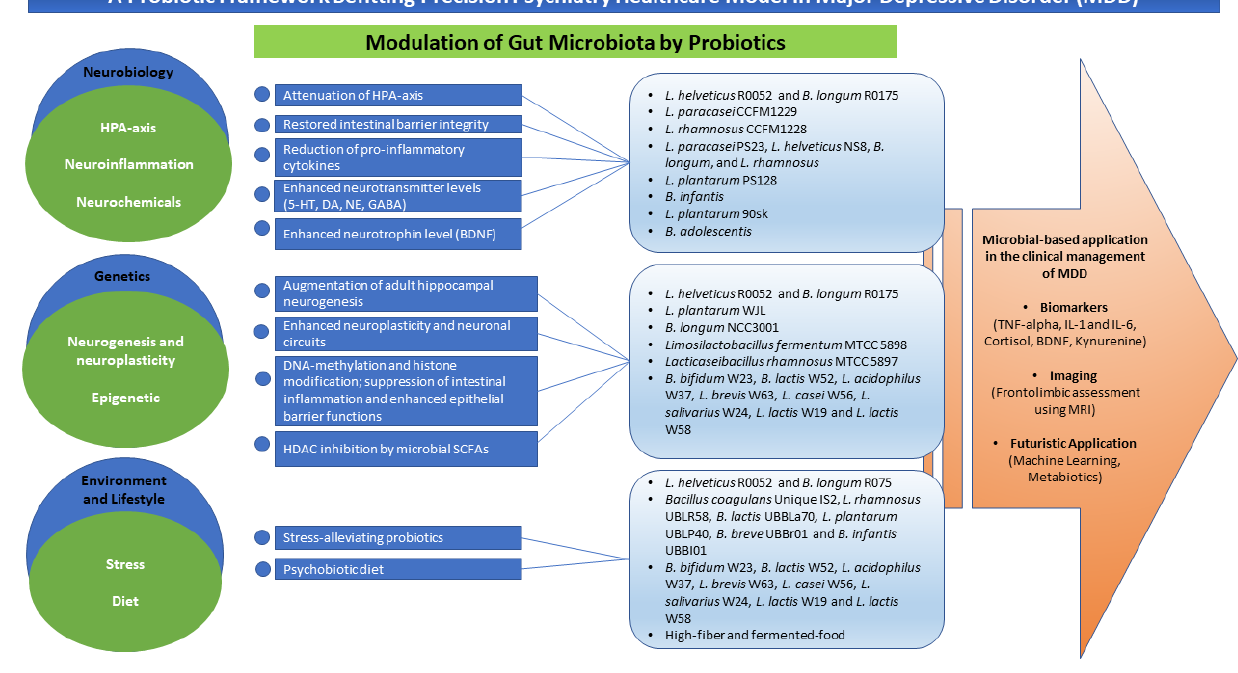
Figure 1. A probiotic framework befitting the precision psychiatry healthcare model in MDD. This framework represents three main components of precision psychiatry: neurobiological bases, genetic bases, and environment and lifestyle elements of MDD that involve microbial intertwining. Modulation of gut microbiota is the rudimentary anti-depressive mechanism of probiotics. Some commonly explored probiotics of Lactobacillus spp. and Bifidobacterium spp., either as a single strain or multi-strain, exert anti-depressive mechanisms by acting on different pathophysiologic mechanisms implicated in depressive disorder. Stress and diet are mainly modifiable targets in the prevention of MDD. The microbial-based applications in the clinical management of MDD include some potential biomarkers obtainable through a patient’s blood analysis, assessment of vital frontolimbic regions in the brain using MRI, and integration of machine learning and development of depression-specific metabiotic as part of futuristic vision within this context.